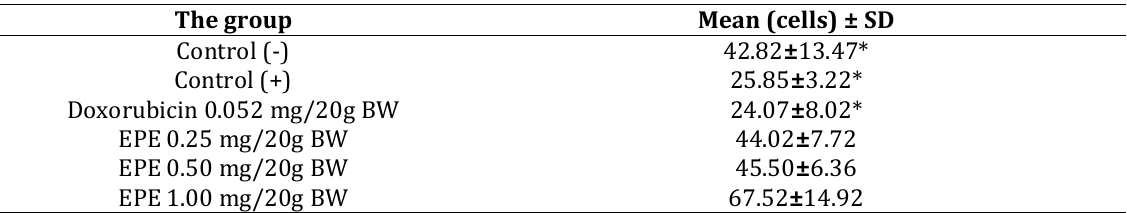
Table III. Mean data of caspase-3 expression in the BALB/c mice colon of the CAC model after treatment with EPE. Caspase-3 expression was observed using a light microscope and count the cytoplasm of colon epithelial cells that changes to brownish